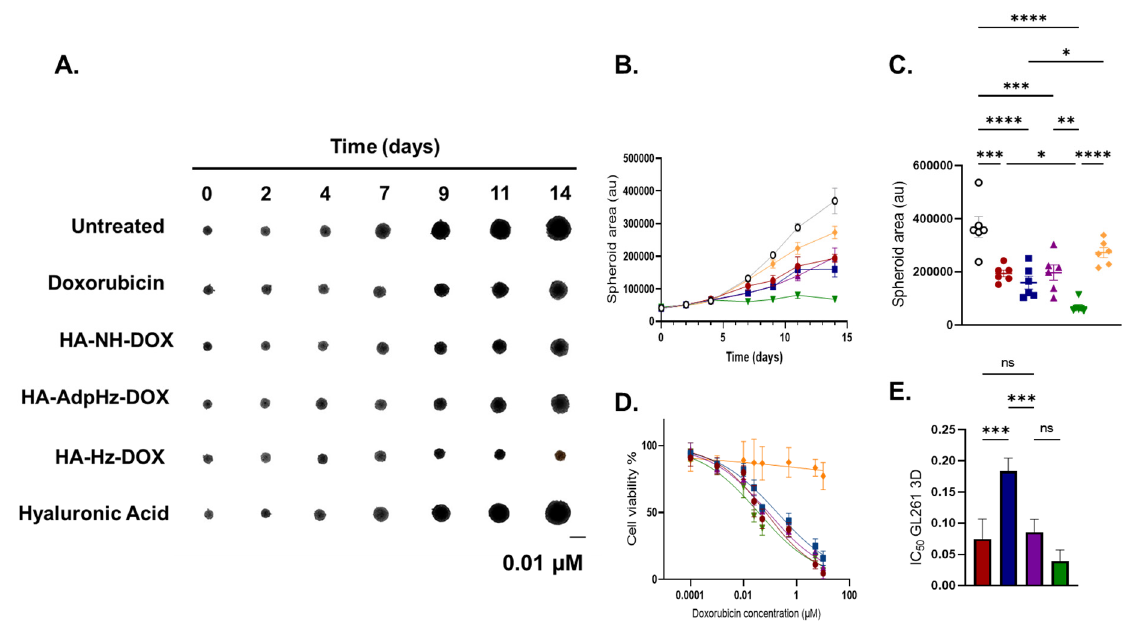
Figure 2. Effect of DOX and HA-DOX conjugates on 3D GL261 spheroids. ( A ) Representative images of 3D cell growth 0–14 days after treatment with 0.01 µ M in DOX equivalent of free DOX, HA, HA-NH-DOX, HA-AdpHz-DOX, and HA-Hz-DOX conjugates; pictures were obtained by using EVOS XL Core Imaging System and processed by ImageJ. ( B ) Three-dimensional cell growth after treatment with free DOX, HA, HA-NH-DOX, HA-AdpHz-DOX, and HA-Hz-DOX conjugates in the range of 0–14 days (0.01 µ M in DOX equivalent). ( C ) Distribution of spheroid area at day 14. ( D ) Three-dimensional cell viability after 15 days of treatment with free DOX, HA, HA-NH-DOX, HA- AdpHz-DOX, and HA-Hz-DOX conjugates in the concentration range of 0.0001–10 µ M. Cell viability was obtained by reading the Alamar blue fluorescence ( λ em : 580 nm, λ ex : 620 nm) and processed through GraphPad (Mean, error bar = SD, N = 4). ( E ) Free DOX, HA-NH-DOX, HA-AdpHz-DOX, and HA-Hz-DOX conjugates’ IC 50 . Data were obtained by cell viability assay on GL261 3D culture and processed through GraphPad (Mean, error bar = SD, N = 4, statistical analysis obtained by one-way ANOVA multiple comparison: ns = not significant, * p < 0.05, ** p < 0.01, *** p < 0.001, **** p < 0.0001). Free DOX: red; HA: yellow; HA-NH-DOX: blue, HA-AdpHz-DOX: violet; HA-Hz- DOX: